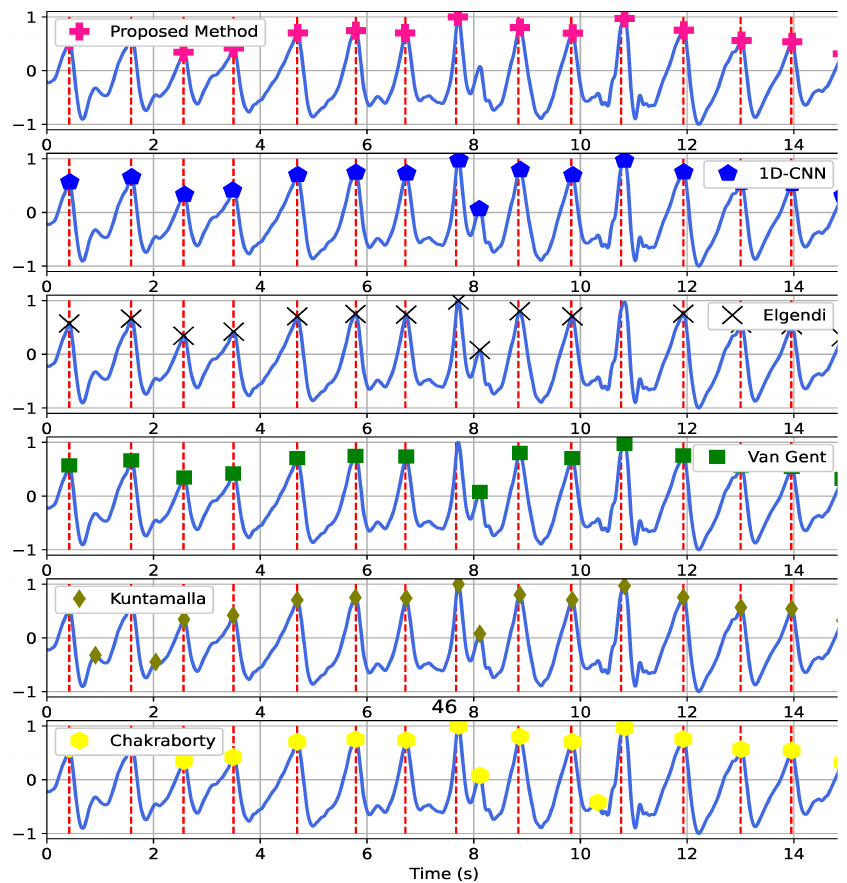
Figure 13. A PPG signal segment with 8.82 dB SNR and the peak detection results obtained by the methods. The vertical dash lines are true peak. The markers show the positions of the peaks detected by the